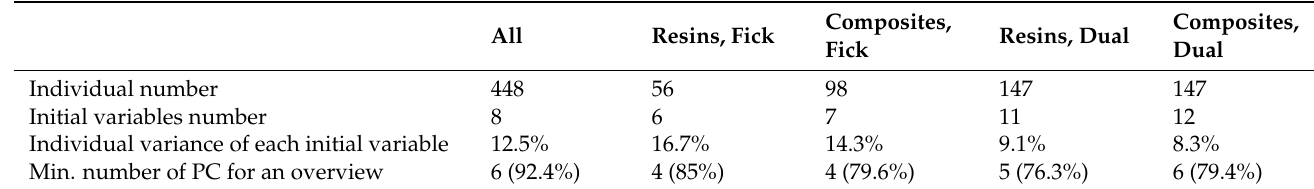
Table 10. Separation of the study individuals into four classified PCA groups. All Resins, Fick